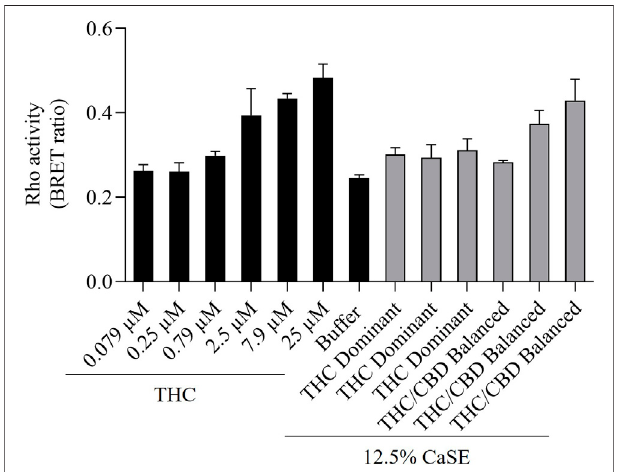
FIGURE 3 | CaSE promotes Rho activation in CB1 expressing cells. HEK293 cells expressing CB1 along with PKN-RBD-RLucII and rGFP-CAAX were stimulated with indicated concentrations of Δ 9 -THC in buffer or 8-fold diluted CaSE (15 µl in total 120 µl assay volume, 12.5% CaSE) from Δ 9 - THC dominant and THC/CBD balanced strains prepared in media with 30% MeOH.TherewasanincreaseinCB1activationinaconcentration-dependent manner by Δ 9 -THC. There was an increase in the activation of CB1 in cells treated with CaSE from THC dominant or THC/CBD balanced cannabis. Buffer was 8-fold dilution of 30% MeOH/DMEM with Tyrode ’ s buffer. Data represent means ± SD of triplicate (THC) and duplicate (CaSE) of a representative experiment. Similar results were obtained with 20 µl or 10 µl application of CaSE.